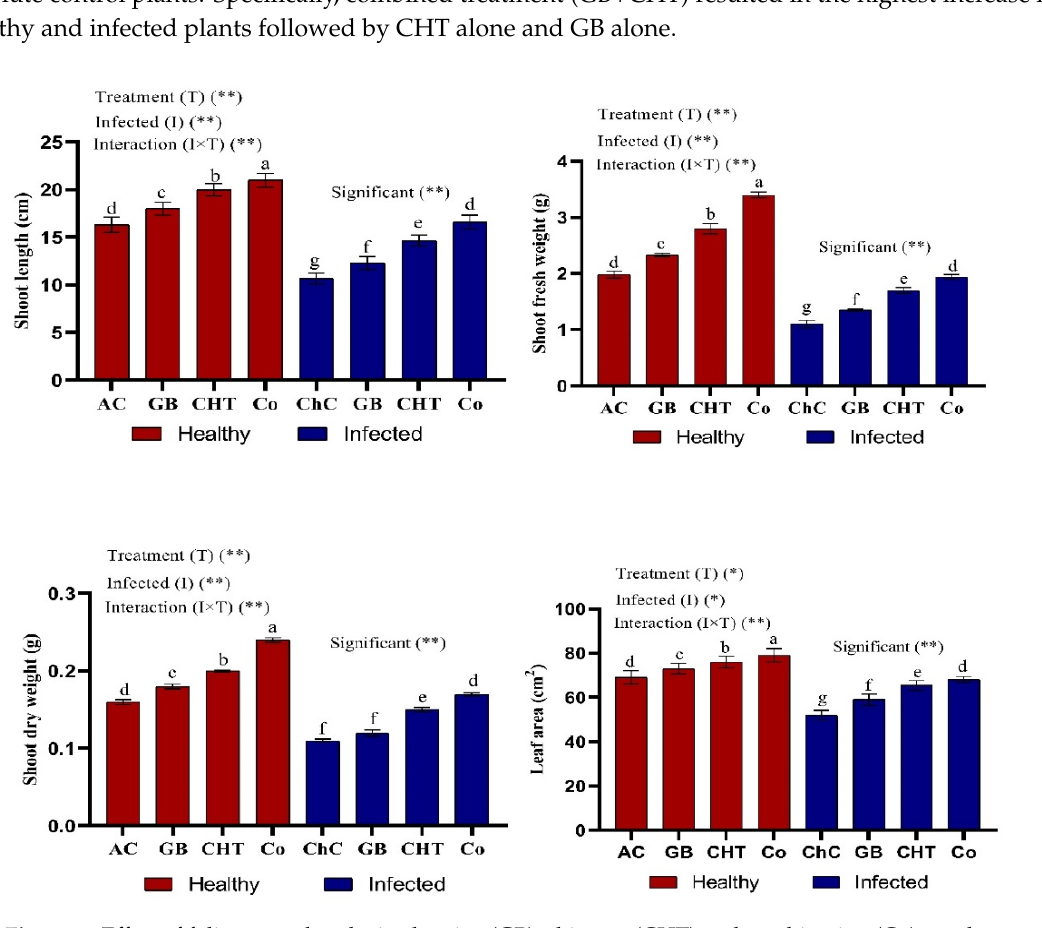
Figure 2. Effect of foliar spray by glycine betaine (GB), chitosan (CHT) and combination (Co) on plant growth of cucumber plant under absolute control (AC) and CMV infection (challenge control, ChC) after 21 days of inoculation. Means with the different letters (a, b, c, d, e, f, g) are significantly different at the 0.05 level among treatments according to Tukey’s test. Vertical bars represent means of ten independent determinations ± standard error (SE). * and ** indicate significant and highly significant difference according to two-way ANOVA with Tukey’s post hoc test.